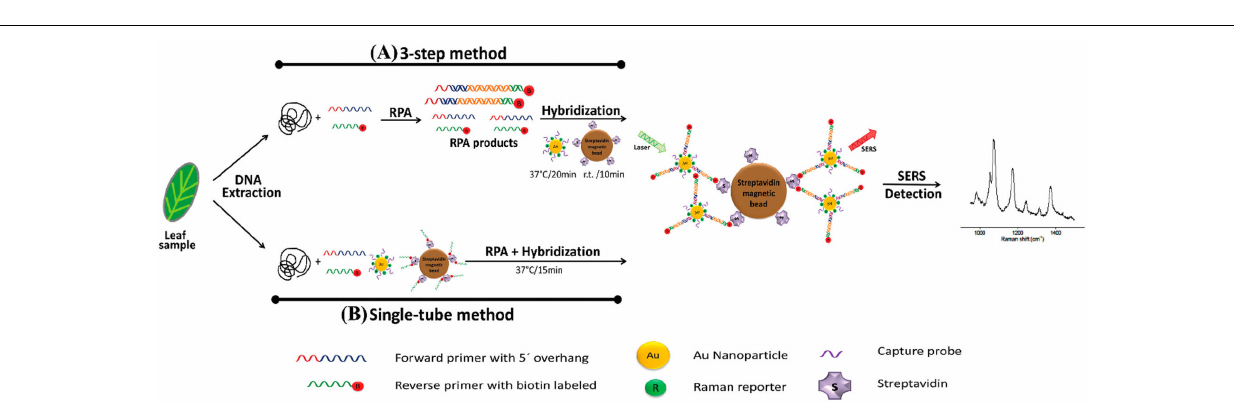
FIGURE 3 | Schematic representation of RPA/SERS multiplex assay (reproduced with permission from Lau et al., 2016). (A) Genomic DNA was extracted using modified Solid Phase Reversible Immobilization (SPRI) method, followed by recombinase polymerase amplification (RPA) using specific biotinylated capture probe. After amplification, biotin/RPA/SERS products were captured by streptavidin magnetic beads. (B) For faster and simpler assessment, SERS nanotags were amplified and hybridized in a single